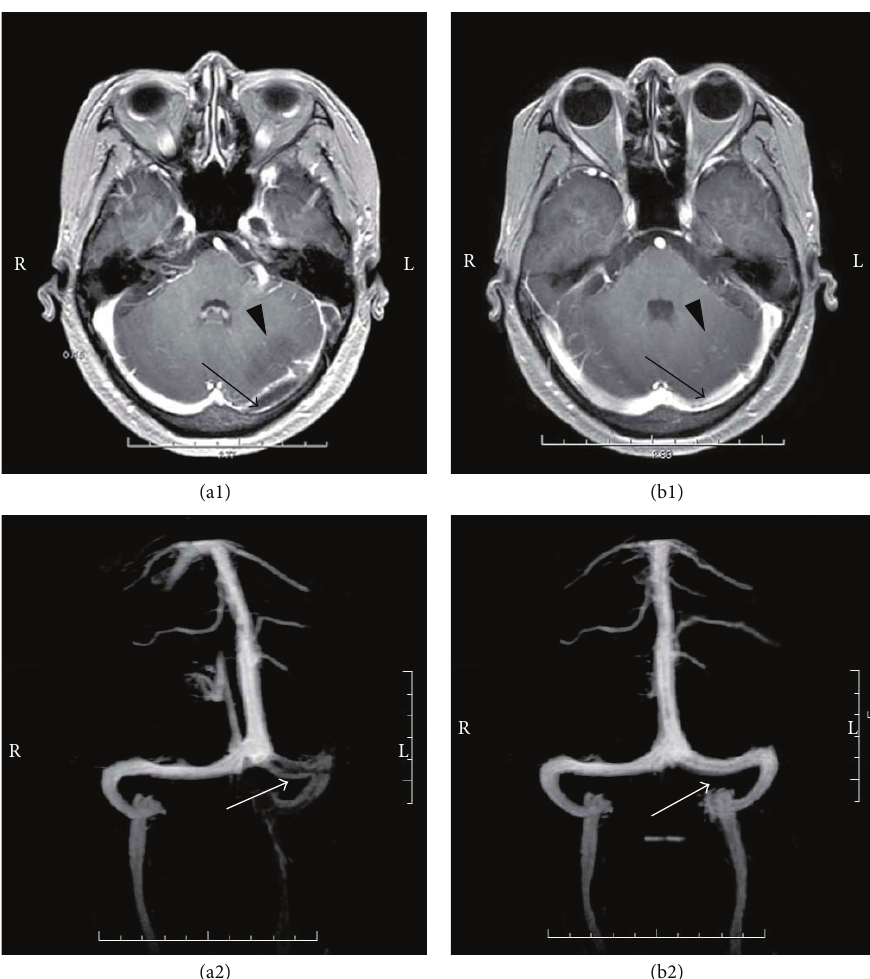
Figure 1: Brain MRI and MRV scan before and after treatment. MRV scan demonstrates loss of signal in the left transverse and sigmoid sinus, representing venous sinus thrombosis before treatment (indicated by arrows on (a1) and (a2)). The signal in the left transverse and sigmoid sinus recovered two months after the initiation of treatment (indicated by arrows on (b1) and (b2)), representing recanalization. MR image shows a patchy hypointense lesion in the left hemisphere of the cerebellum before treatment (indicated by arrow head on (a1)), and this patchy hypointense lesion recovered in the corresponding area after treatment (indicated by arrow head on